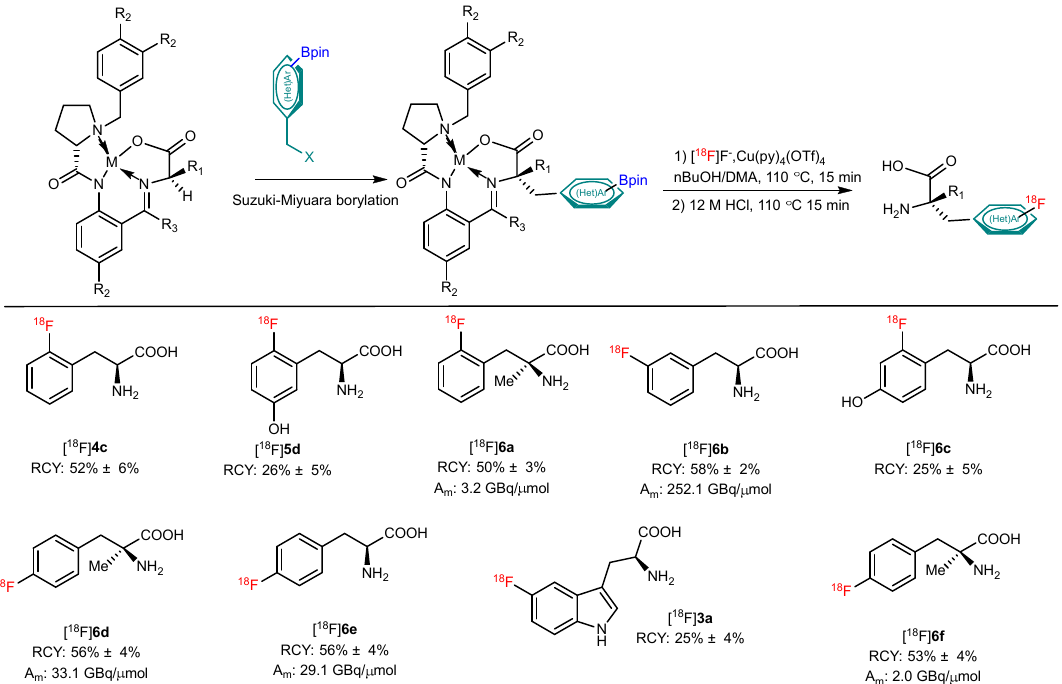
Figure 8. Application of Ni/Cu-BPX templates for the late-stage preparation of 18 F-labeled AAs. Modified from Craig et al. [44].